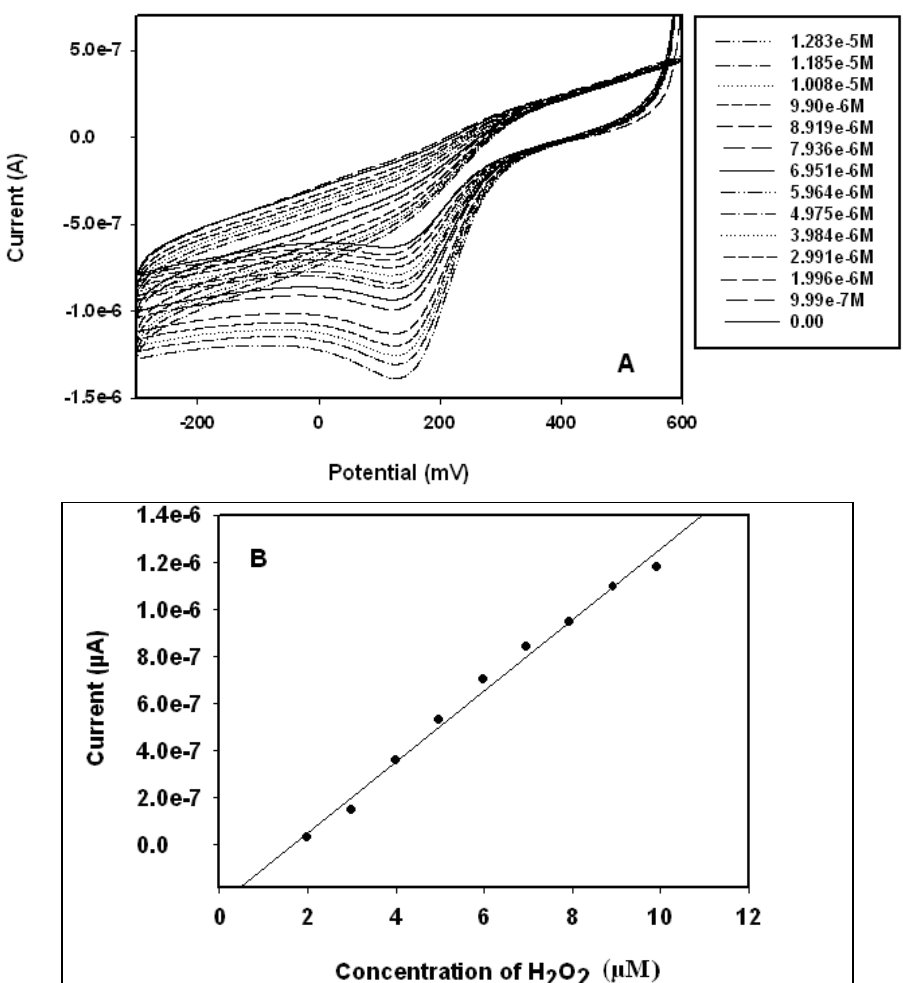
O in 0.1 M 2 2 O 2 2